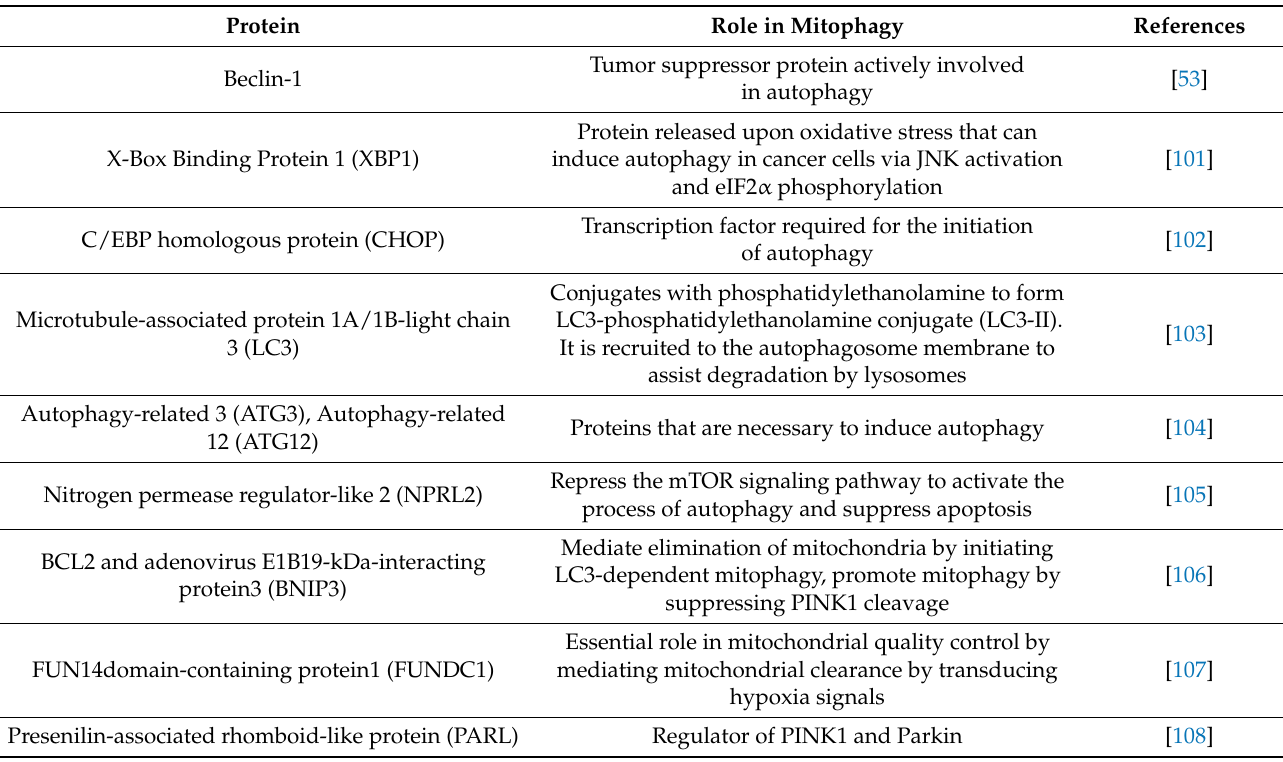
Table 3. Some of the main proteins involved in mitophagy other than PINK1 and